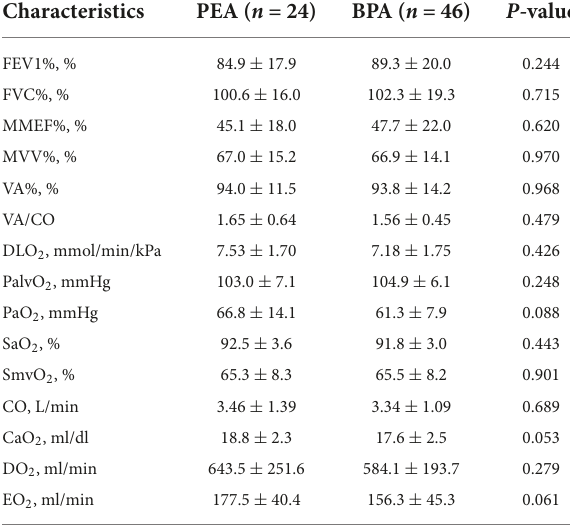
TABLE 2 The oxygen pathway parameters in CTEPH patients before PEA and